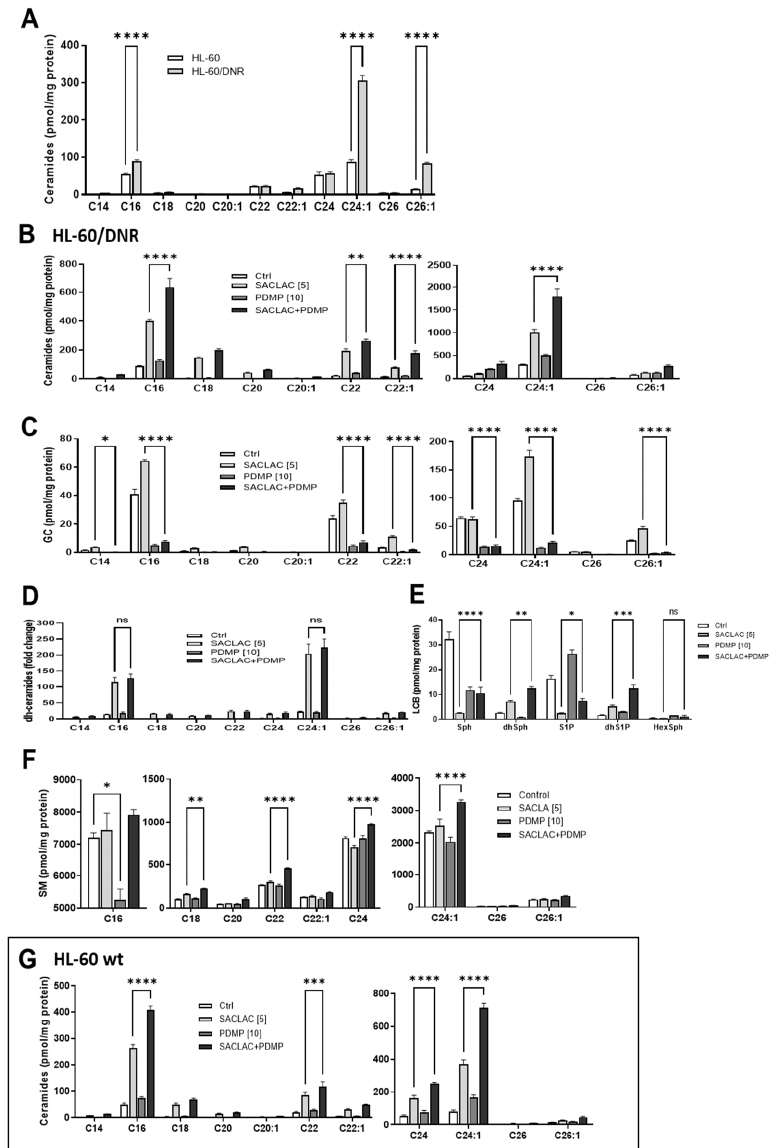
Figure 3. Ceramide levels in HL-60 wt and HL-60/DNR cells and the impact of SACLAC, D- threo -PDMP, and the combination regimen on sphingolipid composition. ( A ) Ceramide levels in HL-60 wt and drug-resistant HL-60/DNR cells. ( B – F ) Impact of SACLAC, D- threo -PDMP, and combination in HL-60/DNR cells on levels of ( B ) Ceramide; ( C ) Glucosylceramide; ( D ) dihydro-Ceramide; ( E ) Long-chain bases; ( F ) Sphingomyelin; and ( G ) Ceramide molecular species in HL-60 wt cells treated with SACLAC, D- threo -PDMP, and combination. Cells (6 × 10 6 /10 cm dish in complete media) were exposed to the control (vehicle, DMSO), SACLAC, D-threo-PDMP, or the combination regimen for 24 h, after which cells were harvested, pelleted by centrifugation, washed 3× in cold phosphate-bu ff ered saline, and stored at − 80 °C. Lipidomic analysis was conducted by mass spectroscopy as indicated in Methods. Results shown are the average of n = 4 experiments. The dh-ceramides levels are given as fold-change due to their low concentrations. GC, glucosylceramide; dh, dihydro; LCB, long-chain base; SM, sphingomyelin; and PDMP, D- threo -PDMP. Data represent Mean ± SEM, ( A ) N = 3–5/group, ( B – F ) N = 3/group, ( G ) N = 6/group. Two-way ANOVA (Tukey’s multiple comparisons test) was used for statistical analysis (* p < 0.05, ** p < 0.01, *** p < 0.001, **** p < 0.0001). ns, not